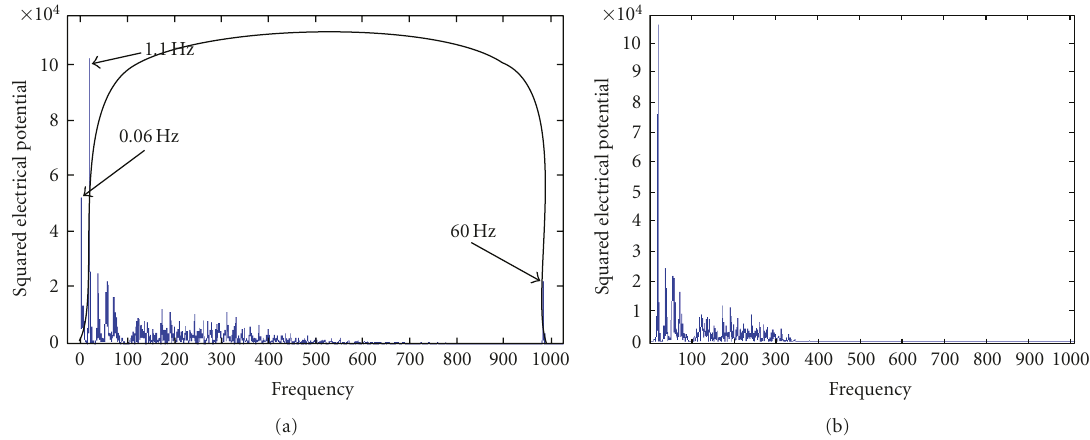
Figure 5: Power spectra of frequency filtering: (a) bandpass filter of raw data (b) frequency response of filtered data. (a) shows the noise source spikes at 0.06 and 60 Hz and the information spikes between 1.10 and 35Hz. (b) shows the filtered data with the noise spikes removed and the subject specific information sources retained. The X -axis is frequency in Hz, and the Y -axis is squared electrical potential.